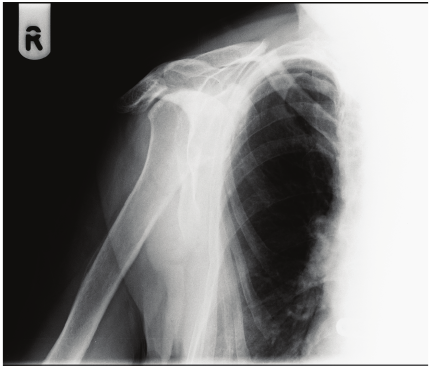
Figure 1: Radiograph taken in A&E department, demonstrating acute transverse right mid-clavicular fracture.